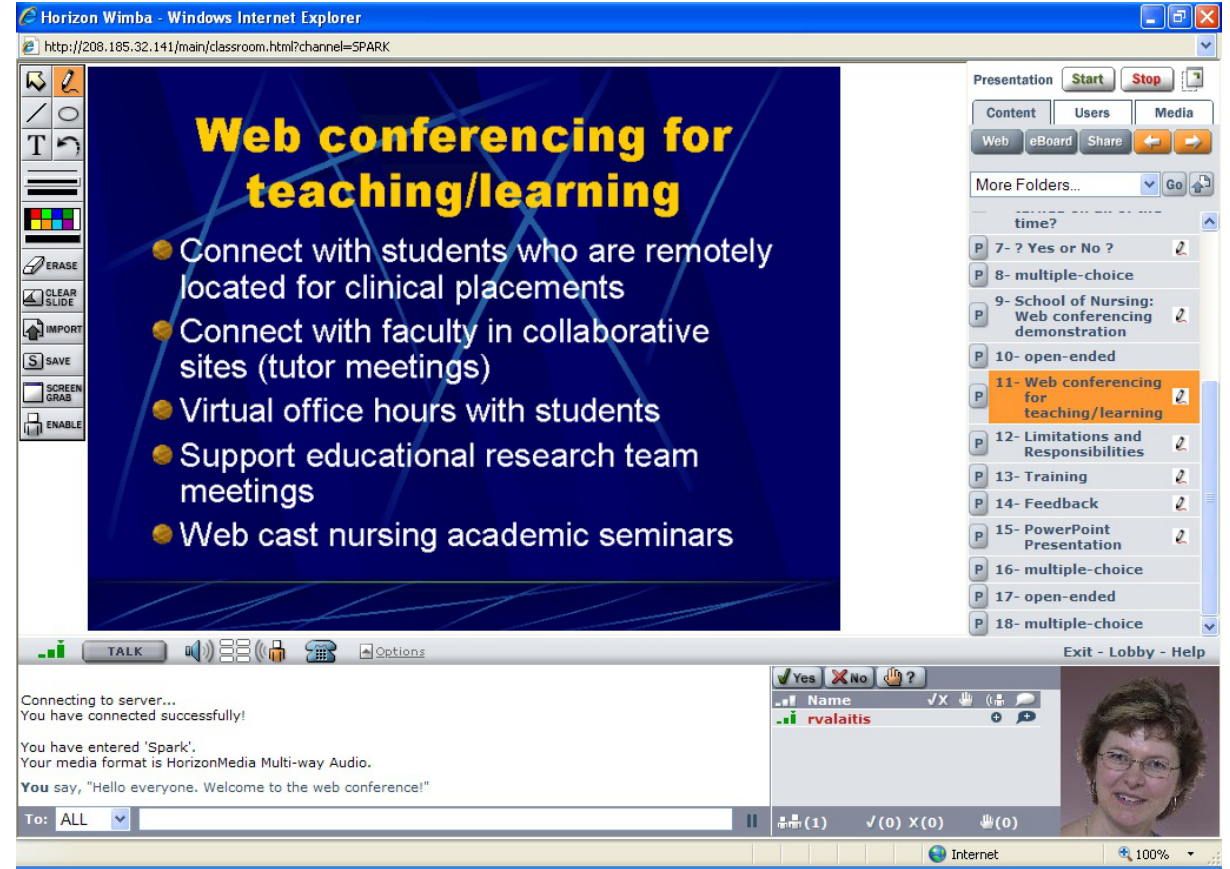
Figure 1. Screen capture of Web conferencing interface of Live